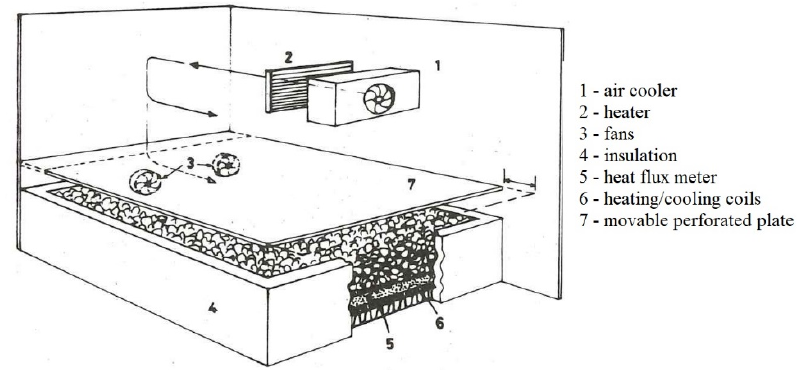
Figure 5. Experimental setup for forced and free convection tests (Johansen, 1975 [2]).